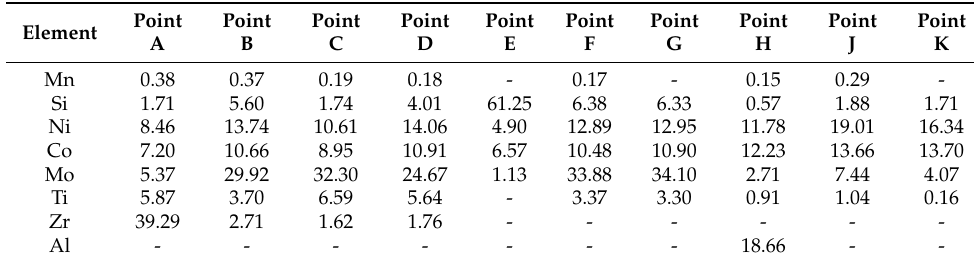
Table 3. Average values of elements content in EDS analysis for points A–K shown in Figure 4. The rest are Fe and